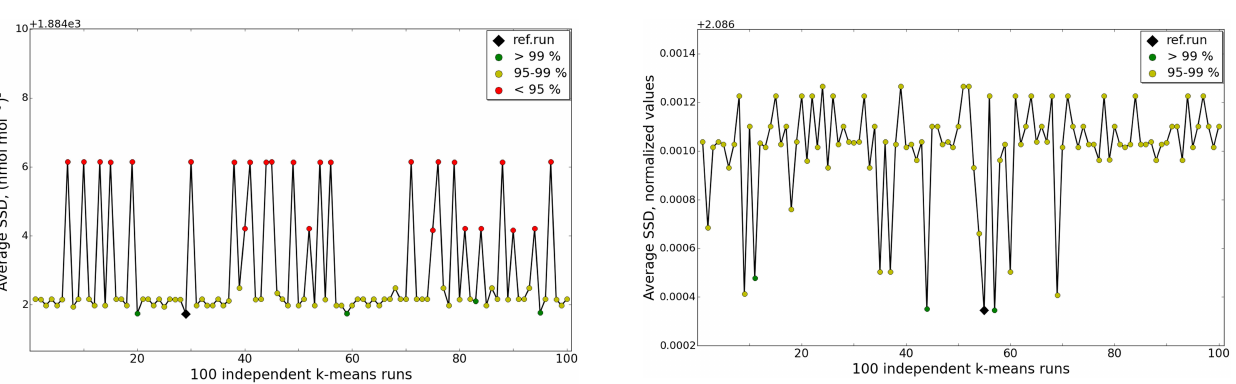
Figure 21. Averaged SSD for 100 independent k -means runs with cluster number k = 4 for all runs; second set of properties. Percent- age ranges in legend indicate similarity of corresponding k -means runs with the second CA reference run presented in this work (black diamond dot). First category: four runs with > 99% similarity; sec- ond category: 96 runs with 95–99% similarity (always at least 95% similarity). Table 6. Robustness analysis of the first CA. The table lists the num- ber of k -means runs (out of 100) where stations are assigned to the same cluster as in the reference run after reducing the data set by randomly removing 10, 20, 30, 40, and 50% of stations. Categories show the percent of similarity to the reference run, i.e., number of stations clustered to the same group as in reference run. Category 3 has the lowest similarity, but at least 89% of the stations were re- producibly assigned to the same